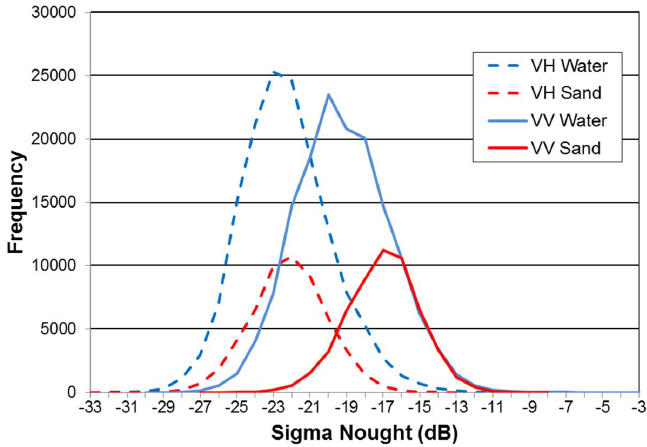
Figure 3. Histograms for water and dark backscattering sand surfaces for VV and VH polarized Sentinel-1 data sets within the validation area in Somalia.